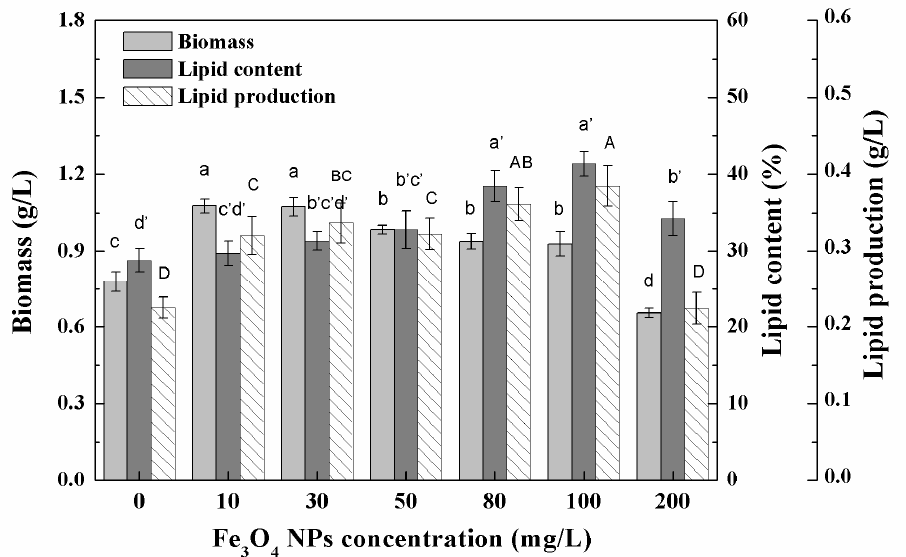
Figure 2. Biomass, total lipid contents, and lipid production of Chlorella sp. UJ-3 exposed to various concentrations of Fe 3 O 4 nanoparticles (Culture time: 21 days; Different letters on the top of column indicate significant differences between means: a, b, c, d; a’, b’, c’, d’; A, B, C, D; p < 0.05).